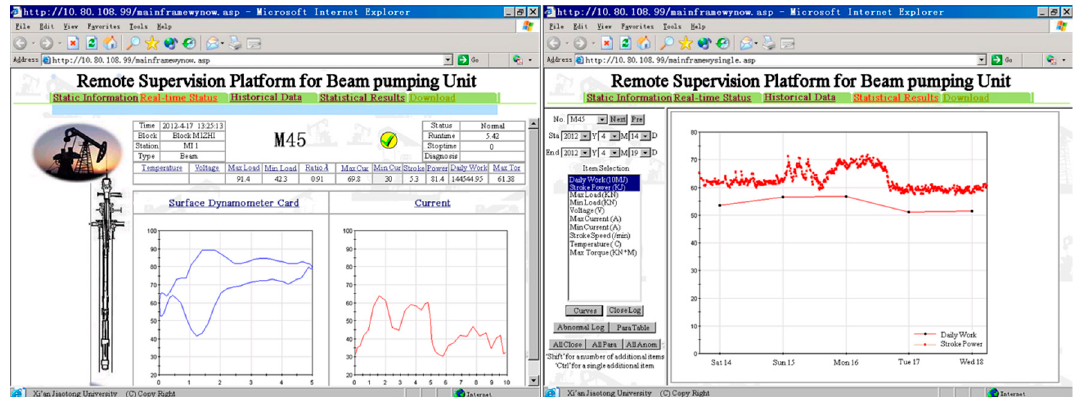
Figure 6. Partial information of the No. M45 beam pumping unit in the remote supervision platform. ( a ) Real-time status; and ( b ) statistics of motor